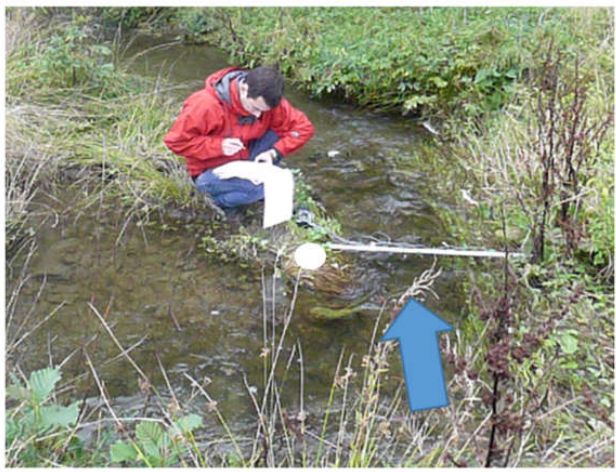
Figure 9. Photograph of the measured channel section for the Koulbich. (picture J. Klaus) Bioengineering 2017, 4, x FOR PEER REVIEW